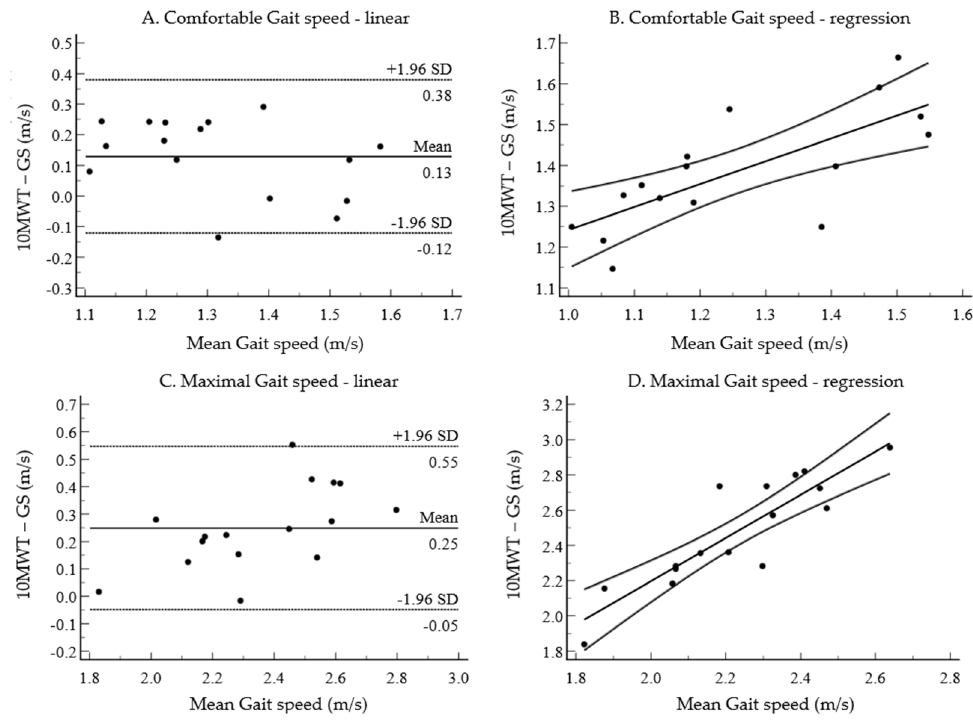
Figure 2. Bland–Altman plots. Relationship between mean gait speed of 10 MWT and GAITRite (GS) and difference between comfortable gait speed measurements ( A , B ) and maximal gait speed measurements ( C , D ). Mean difference values of ( A , C ) (center line) and linear LOA (upper and lower lines) are shown. The number to the right of each line is the y value. Lines ( B , D ) show the regression-based line of best fit (center line) and regression-based LOA (upper and lower lines) calculated from the standard deviation of residuals.